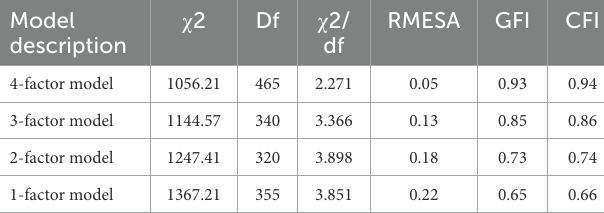
TABLE 2 Confirmatory factor analysis